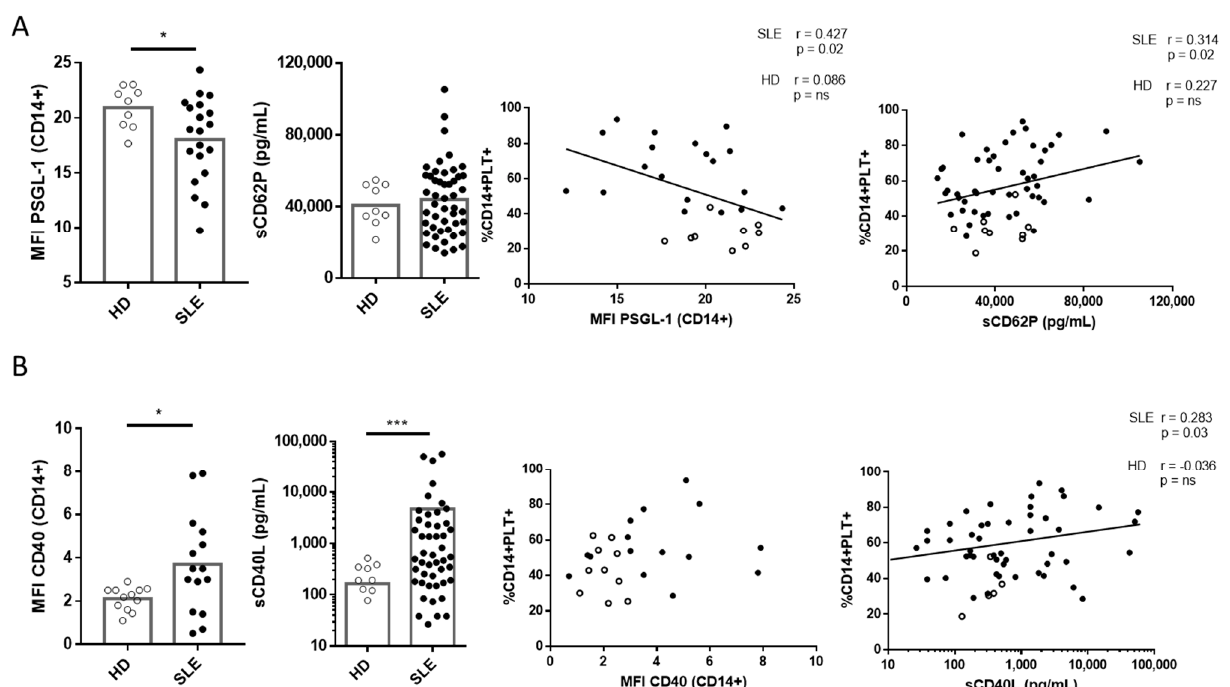
Figure 5. Expression of PSGL-1 and CD40 on monocytes and quantification of soluble CD62P (sCD62P) and CD40L (sCD40L) in plasma from HD and SLE patients and their association with the percentage of monocytes with bound platelets (CD14+PLT+). ( A ) PSGL-1 gMFI of monocytes from HD ( n = 9) and SLE patients ( n = 20). Levels of sCD62P in plasma from HD ( n = 9) and SLE patients ( n = 49). PSGL-1 and sCD62P correlations with the percentage of CD14+PLT+. ( B ) CD40 MFI of monocytes from HD ( n = 12) and SLE patients ( n = 15). Levels of sCD40L in plasma from HD ( n = 9) and SLE patients ( n = 49). CD40 and sCD40L correlations with the percentage of CD14+PLT+. White circles represent HD, and black circles represent SLE patients. Statistical analysis was performed using the Mann–Whitney test for comparisons between HD and SLE and Pearson’s (PSGL-1 and sCD62P) or Spearman’s (CD40 and sCD40L) correlation for correlation analysis. * p < 0.05, *** p <